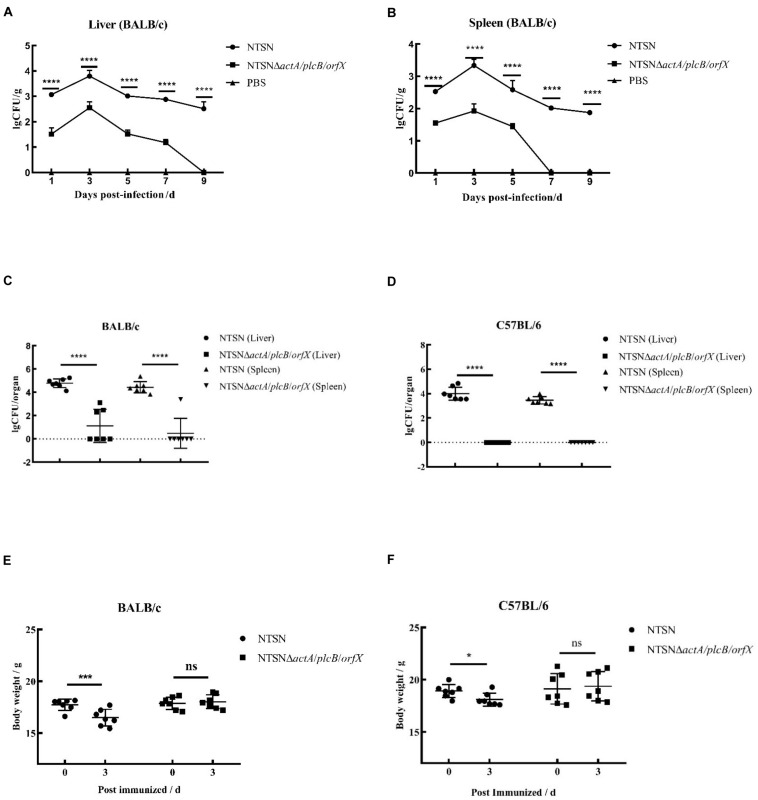
Bacterial loads and body weight changes in infected mice. Over time 6 mice in each group were abdominally injected with either NTSNΔactA/plcB/orfX (5 × 105 CFU), NTSN (5 × 103 CFU), or PBS (150 mL). (A) Polyline with round black dots indicated the number of viable bacteria in the liver enumerated of the BALB/c mice infected by NTSN at 1, 3, 5, 7, and 9 days post-infection; While polyline with square black dots represented the BALB/c mice infected by NTSNΔactA/plcB/orfX; And polyline with triangular black dots represented the BALB/c mice were injected by PBS. (B) Polyline with round black dots indicated the number of viable bacteria in the spleen enumerated of the BALB/c mice infected by NTSN at 1, 3, 5, 7, and 9 day post-infection; While polyline with square black dots represented the BALB/c mice were infected by NTSNΔactA/plcB/orfX; And polyline with triangular black dots represented the BALB/c mice were injected by PBS. The log CFUs/g represented the mean of six mice per group. Each dot represented an organ from one infected mouse. Error bars represented SD, n = 3 independent experiments. Statistical analyses were carried out by Tukey’s multiple comparisons test: ****P < 0.0001. (C) The round black dots indicated to the bacterial load in the liver of BALB/c mice post NTSN infected 3 days; The square black dots indicated to the bacterial load in the liver of BALB/c mice post NTSNΔactA/plcB/orfX infected 3 days; and the equilateral triangle black dots presented the bacterial load in the liver of BALB/c mice post NTSN infected 3 days; The inverted triangle black dots indicated to the bacterial load in the liver of BALB/c mice post NTSNΔactA/plcB/orfX infected 3 days (Log CFU/organ). (D) The round black dot refers to the bacterial load in the liver of C57BL/6 mice post NTSN infected 3 days; The square black dots indicated the bacterial load in the spleen of C57BL/6 mice post NTSNΔactA/plcB/orfX infected 3 days; and the equilateral triangle black dots indicated the bacterial load in the liver of C57BL/6 mice post NTSN infected 3 days; The inverted triangle black dots indicated the bacterial load in the spleen of C57BL/6 mice post NTSNΔactA/plcB/orfX infected 3 days (Log CFU/organ). Body weight changes post infected mice at 3 days compared them with the pre-infection for statistical analysis. The log CFUs/organ represented the mean of seven mice per group. Each dot represents an organ from one infected mouse. Error bars represented SD, n = 3 independent experiments. Statistical analyses were carried out by Tukey’s multiple comparisons test: ****P < 0.0001. (E) Body weight changes of BALB/c mice post NTSN and NTSNΔactA/plcB/orfX strain infection. (F) Body weight changes of BALB/c mice after NTSN and NTSNΔactA/plcB/orfX strain infection. Statistical analyses were carried out by Sidak’s multiple comparisons test: ****P < 0.0001, ***P < 0.001, *P < 0.05, compared to the corresponding control group.